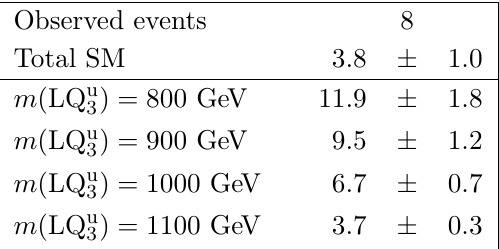
Table 3 . The number of observed events in the cut-and-count SR tN high, together with the expected number of background events including their total uncertainties, taken from ref. [22]. Additionally, the expected number of signal events are given for B = 0 for up-type LQs of di(cid:11)erent masses with statistical